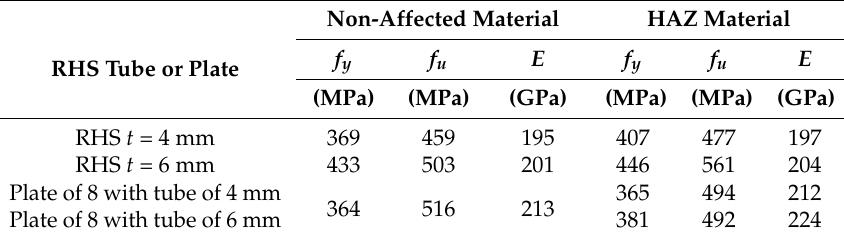
Table 1. Actual material properties in base material and HAZ.